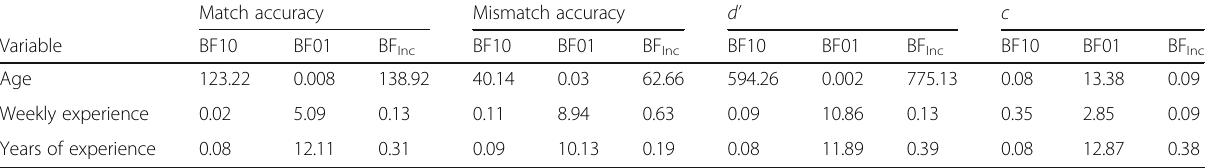
Table 2 Bayes Factors (BFs) for each predictor variable on accuracy and signal-detection measures